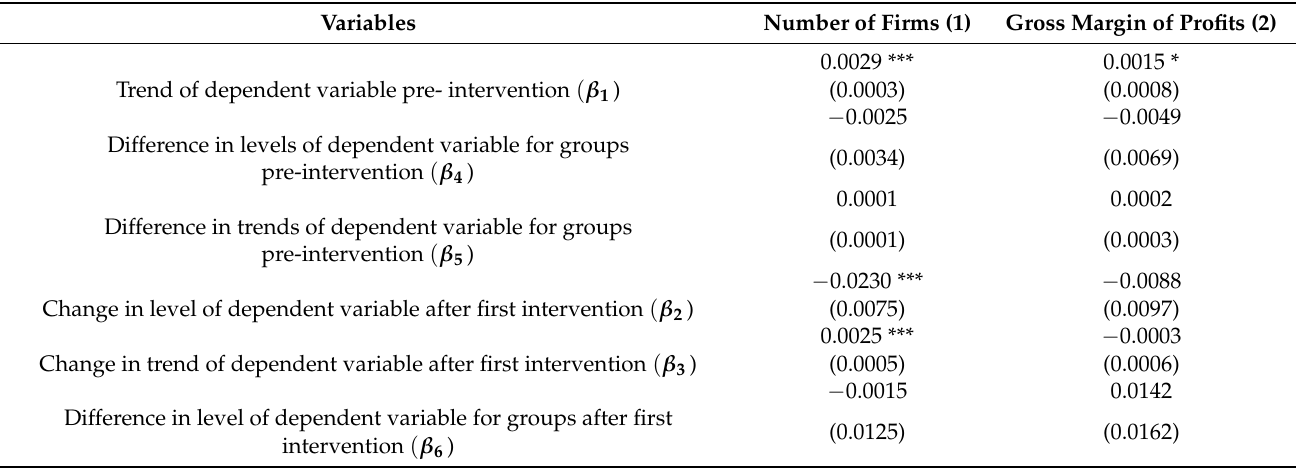
Table A3. Changes in the number of firms and the gross margin of profit (including expenditures on capital goods) after two stages of FOP